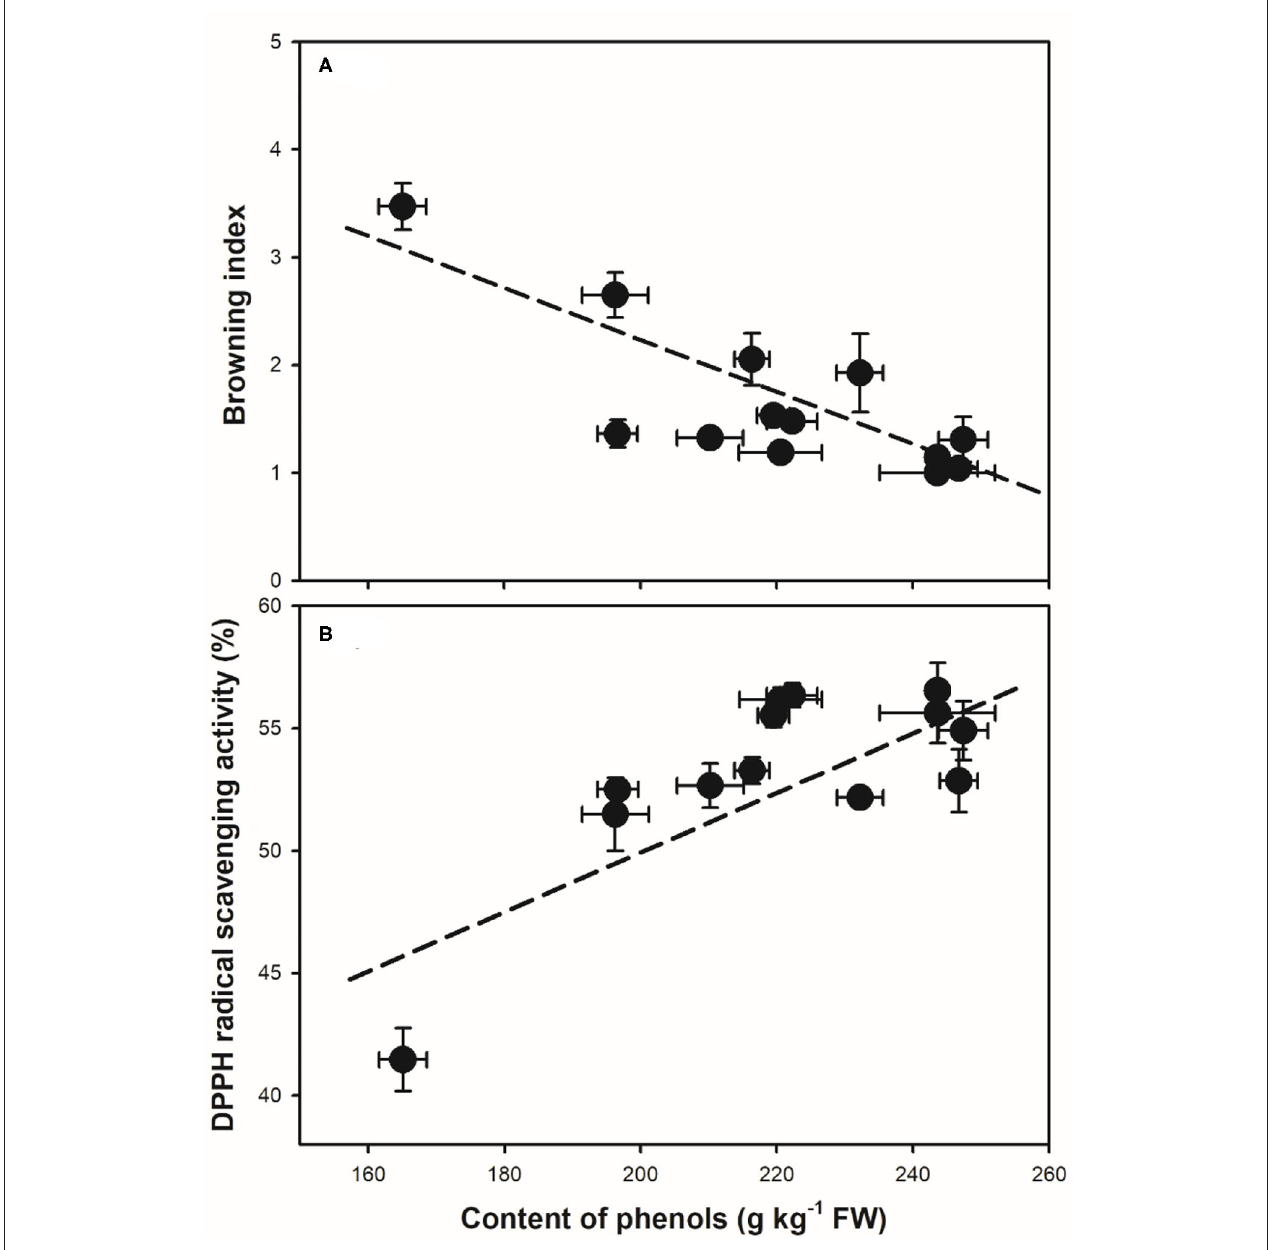
FIGURE 6 | Correlation analysis between the content of pericarp phenols and the changes in (A) browning index ( r = − 0.83, p < 0.01), and (B) the DPPH radical scavenging capacity ( r = 0.78, p < 0.01) during storage. Data of mean values with the SD were used in the correlation